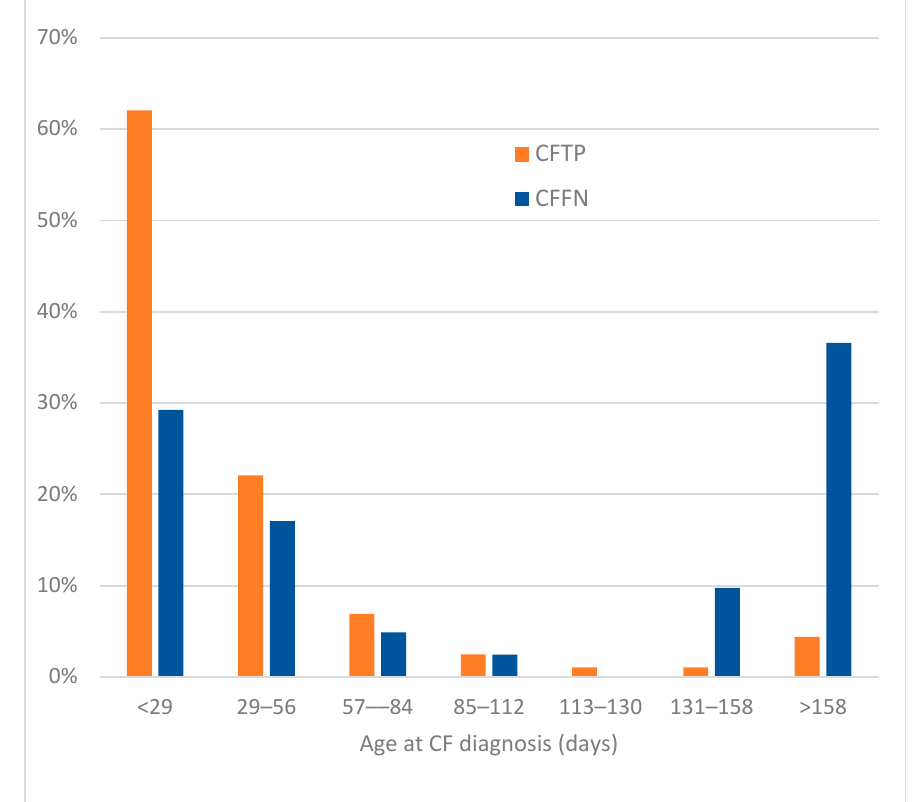
Figure 3. Percentage of 41 CFFN and 1545 CFTP cases by age at CF diagnosis in 12 states.